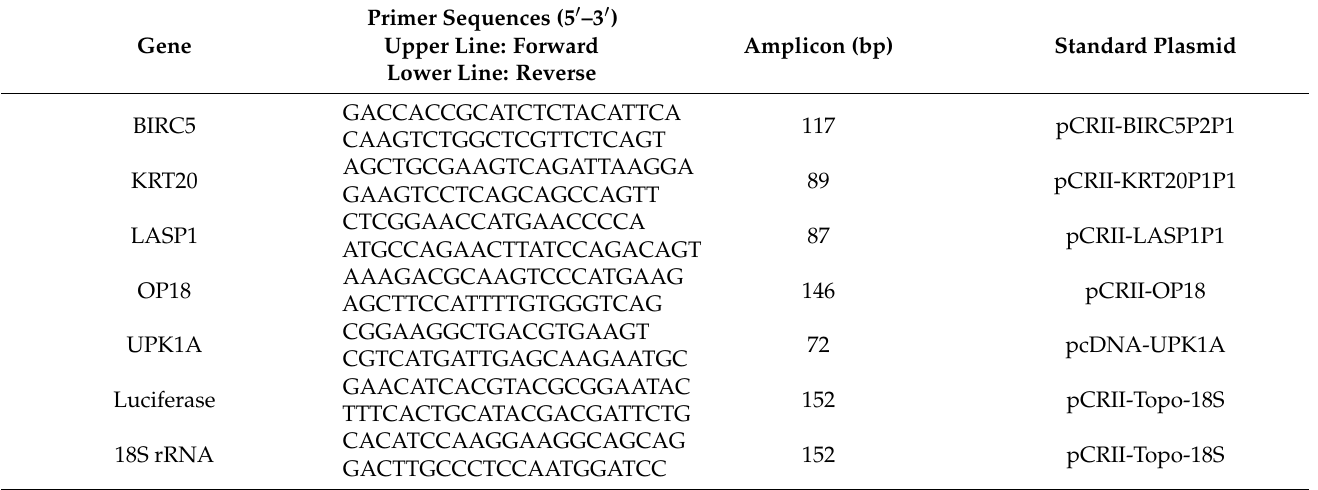
Table 2. Primer pairs and length of PCR amplicons for genes listed in the first column. The plasmid names of cloned standards are listed in the last column.